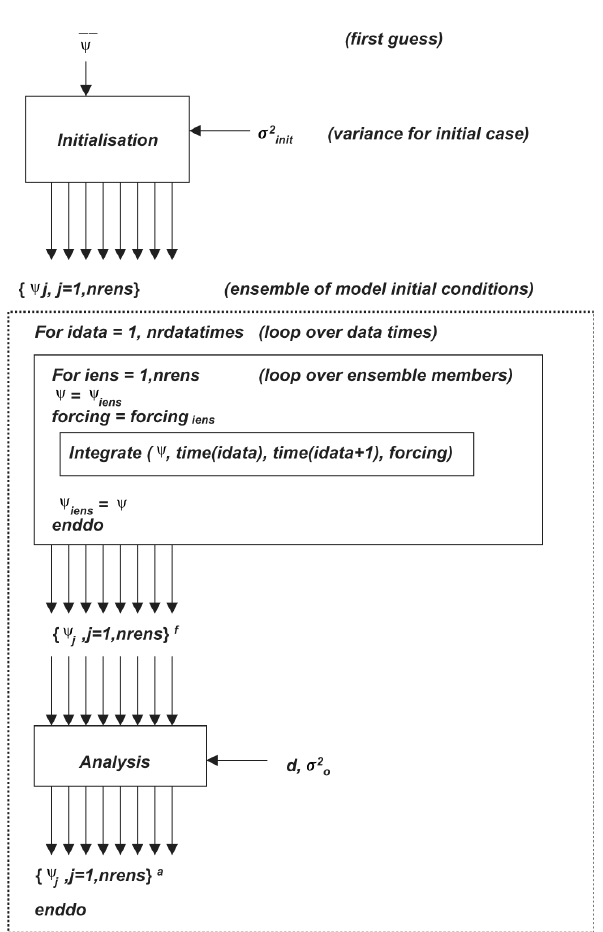
Fig. 2. Schematic figure showing how the EnKF methodology is in relationship to an arbitary model. Nrens is the ensemble size, irens is the number of the ensemble being integrated and is the data used for